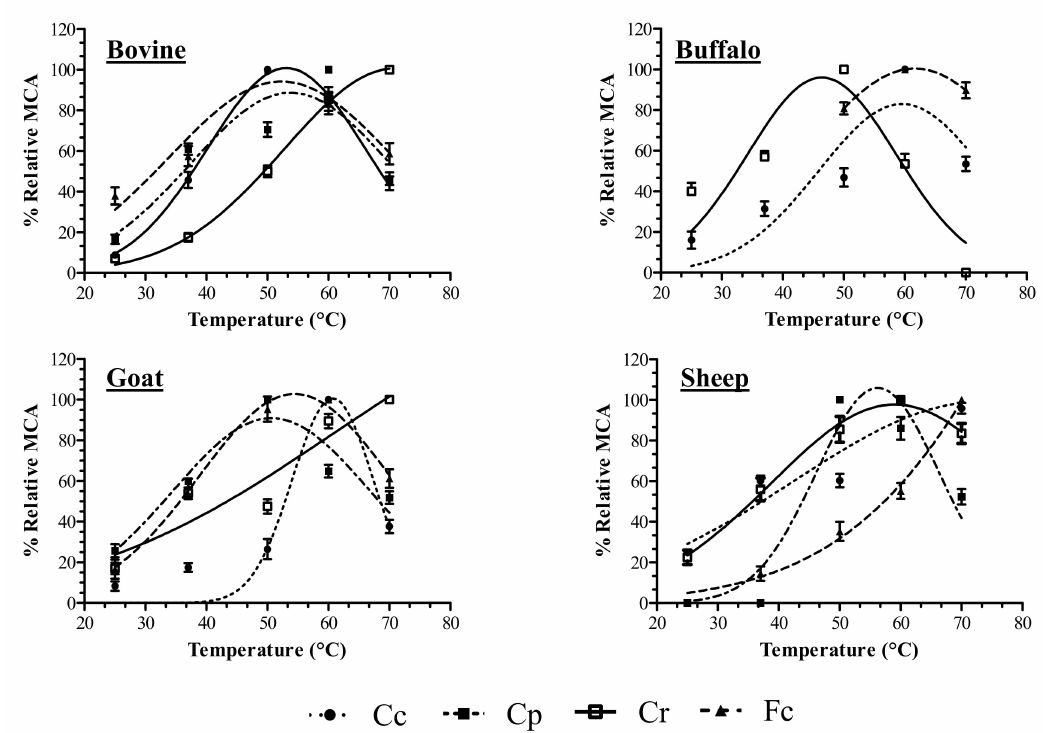
Figure 1. Temperature e ff ect on the milk-clotting activity (MCA) of Cynara cardunculus (Cc), Carica papaya (Cp), calf rennet (Cr) and Ficus carica (Fc) extracts, measured in bovine, bu ff alo, goat and sheep milks. The percentage (%) relative MCA represents the mean of three independent determinations performed in triplicated for each